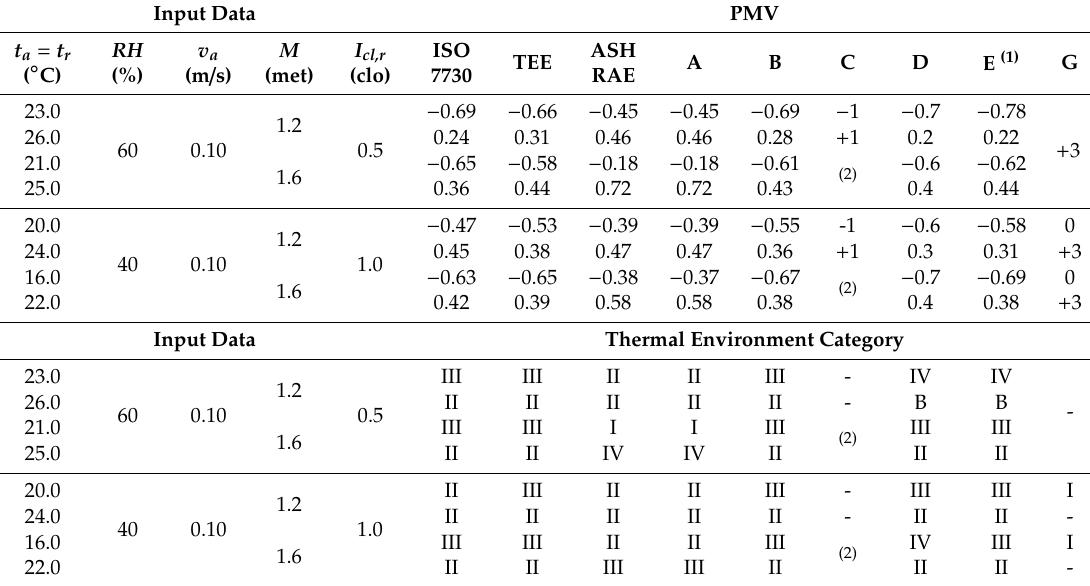
Table 6. PMV values and comfort categories obtained with the investigated software and comparison with values from ISO 7730 tables. Relative velocity has been calculated according to Equation